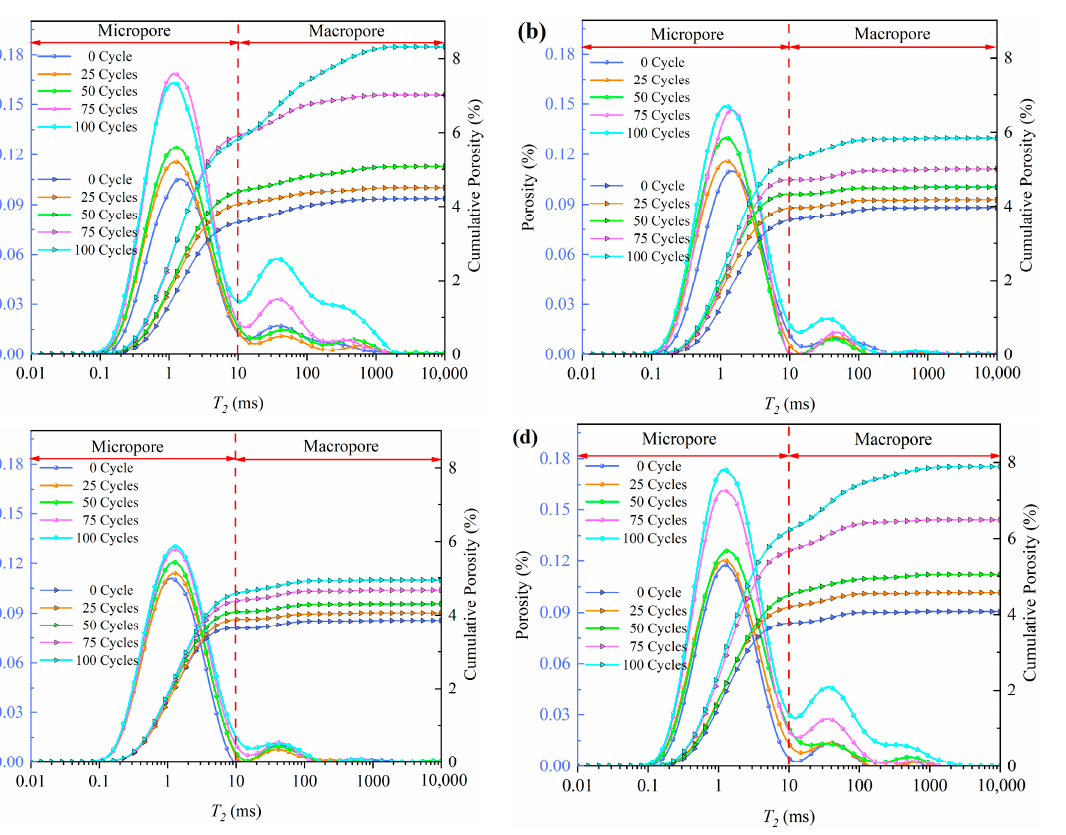
Table 2. Porosity change rates of four groups after different cycles (%).